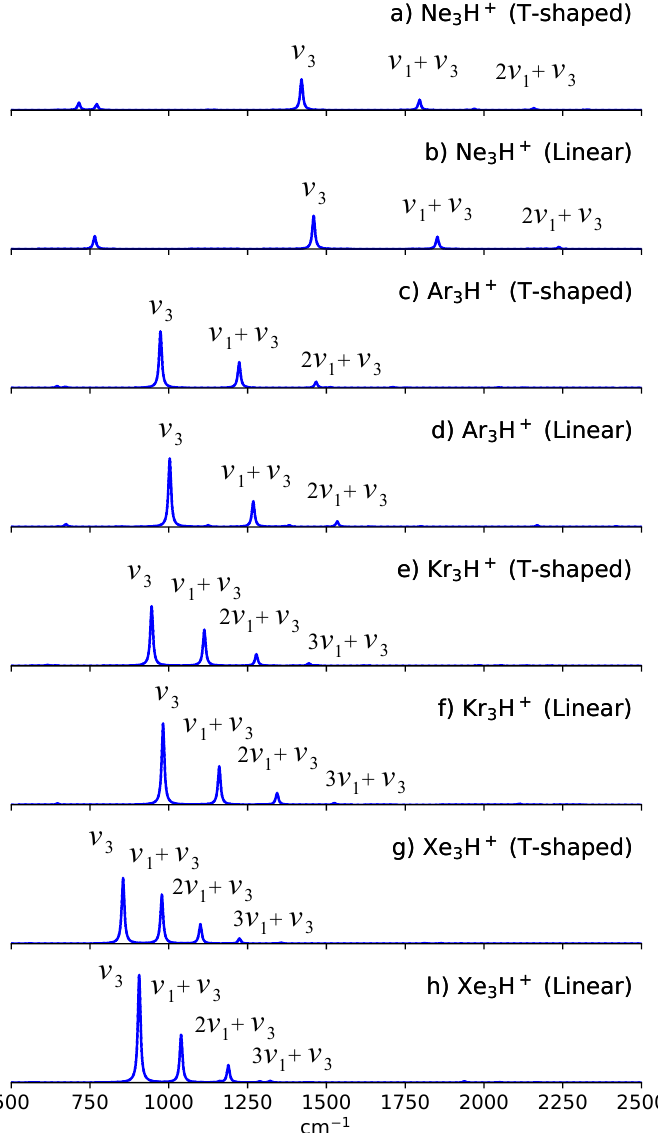
Figure 4. Anharmonic spectrum for ( a ) Ne 3 H + (T-shaped), ( b ) Ne 3 H + (Linear), ( c ) Ar 3 H + (T- shaped), ( d ) Ar 3 H + (Linear), ( e ) Kr 3 H + (T-shaped), ( f ) Kr 3 H + (Linear), ( g ) Xe 3 H + (T-shaped), and ( h ) Xe 3 H + (Linear). Subplots ( c , d ) are adapted with permission from Ref. [59]. Copyright 2020 American Chemical